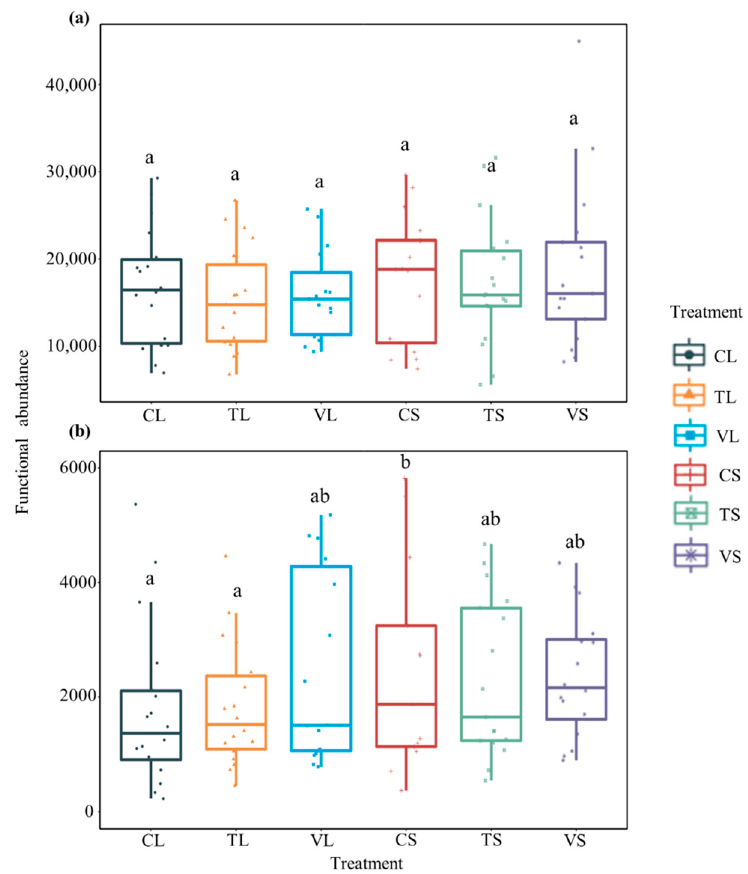
Figure 2. Abundance of bacteria related to C cycle ( a ) and N cycle ( b ) under different treatments in leaf and stem litter. C, ambient temperature; T, +4 °C constant warming; V, variable warming; L, leaf litter; S, stem litter. All data are presented as mean ± SE. The letters above the bars represent significant differences between treatments ( p < 0.05, Tukey’s test).